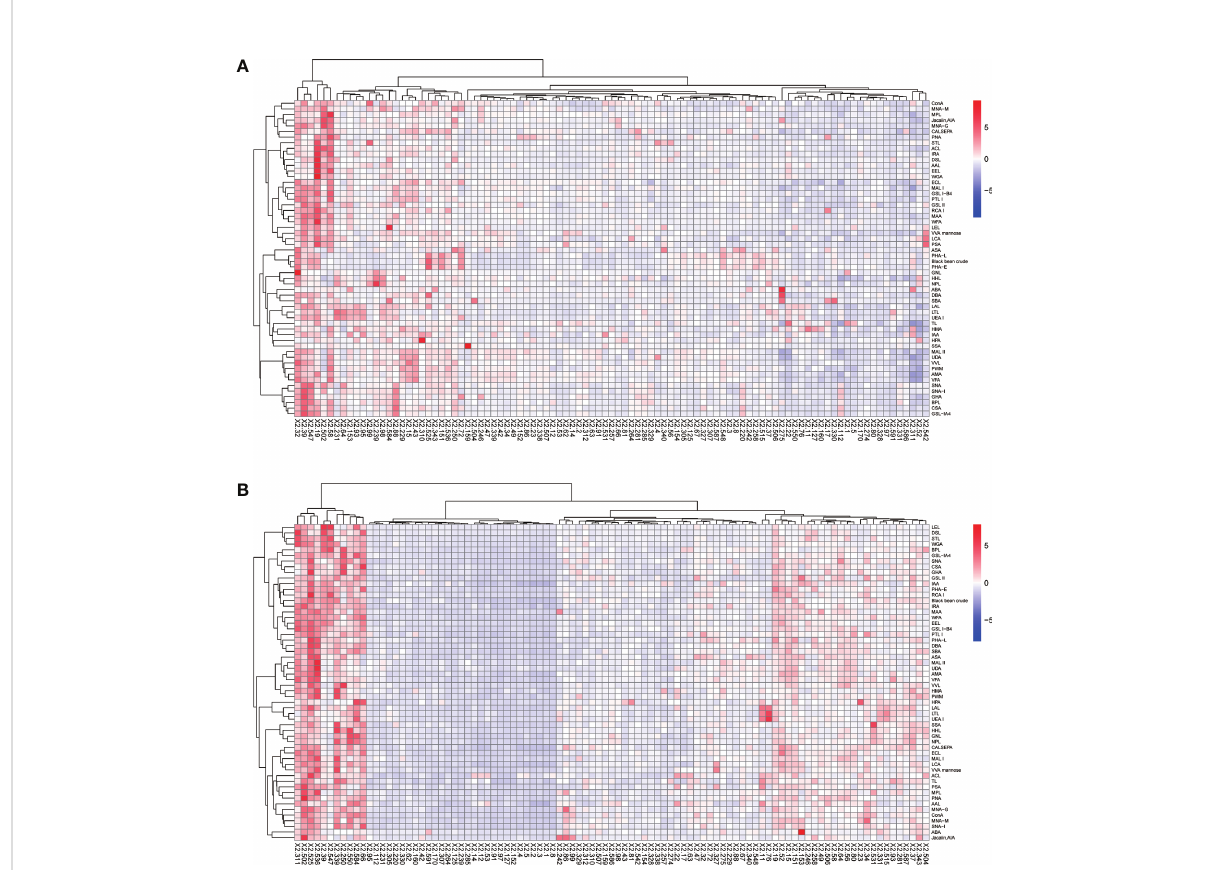
FIGURE 1 Heatmap of lectins in patients with HCC. (A) Lectins of serum IgG. (B) Lectins of serum IgM. Red indicates overexpression and blue underexpression. The columns correspond to the 97 HCC